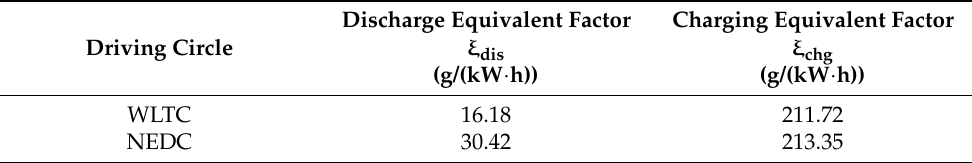
Table 4. The equivalent factors under the WLTC and the NEDC cycles.